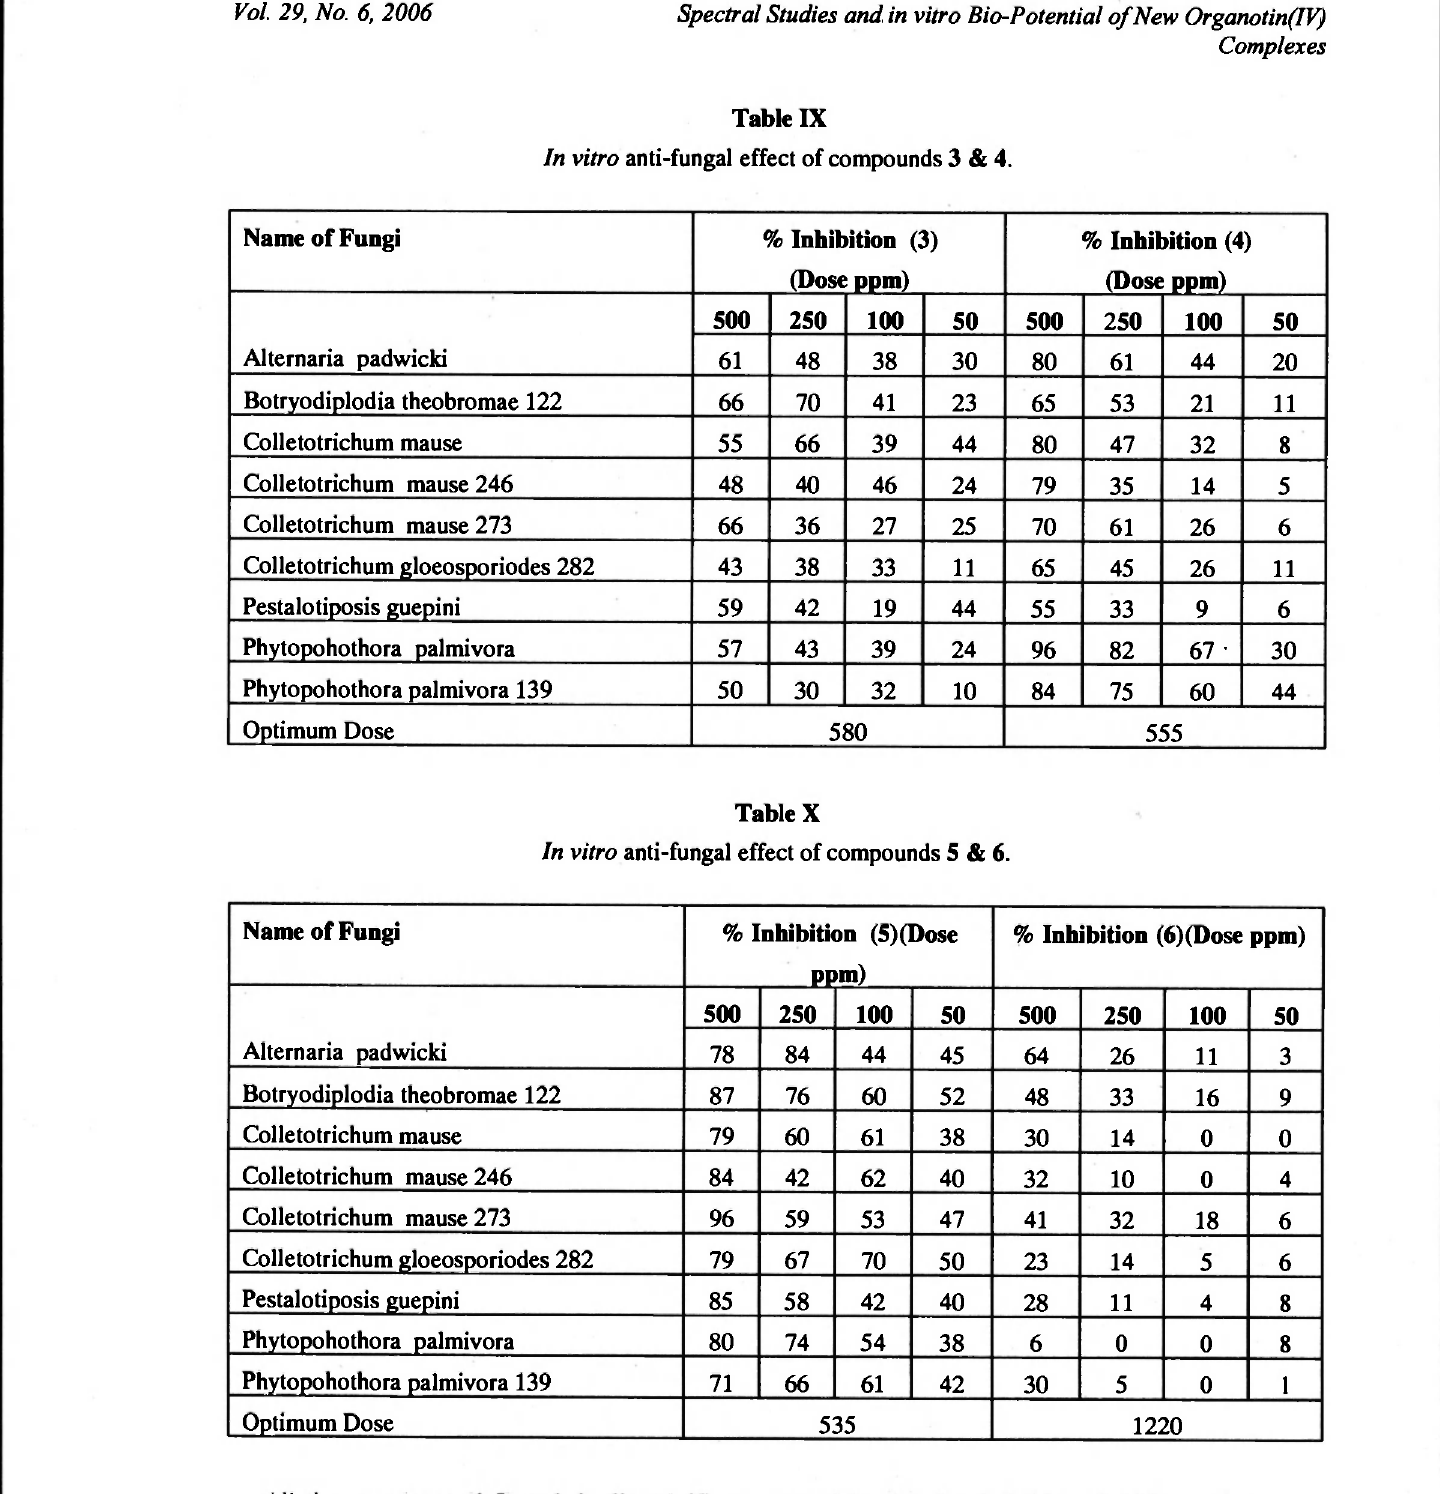
In vitro anti-fungal effect of compounds 5 &